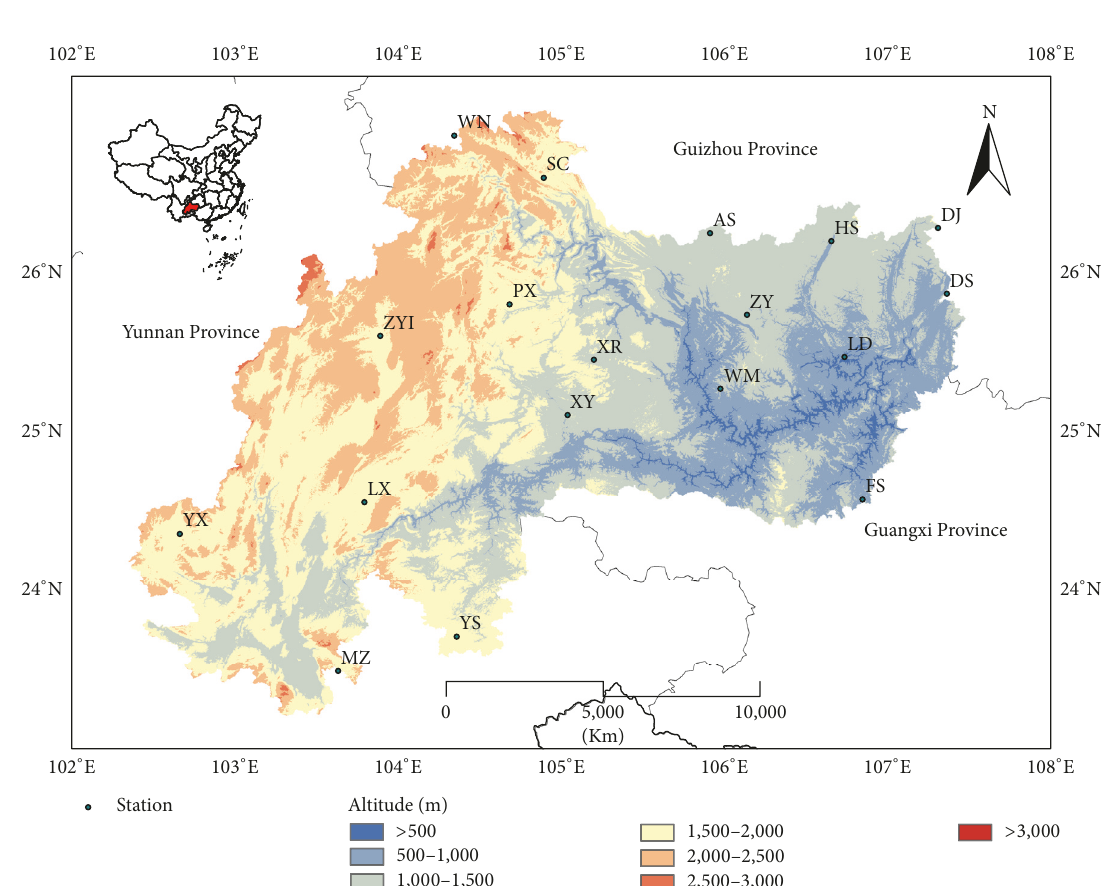
Figure 1: Locations of the 18 meteorological stations plotted on a digital elevation model of the upper reaches of the Hongshui River basin,